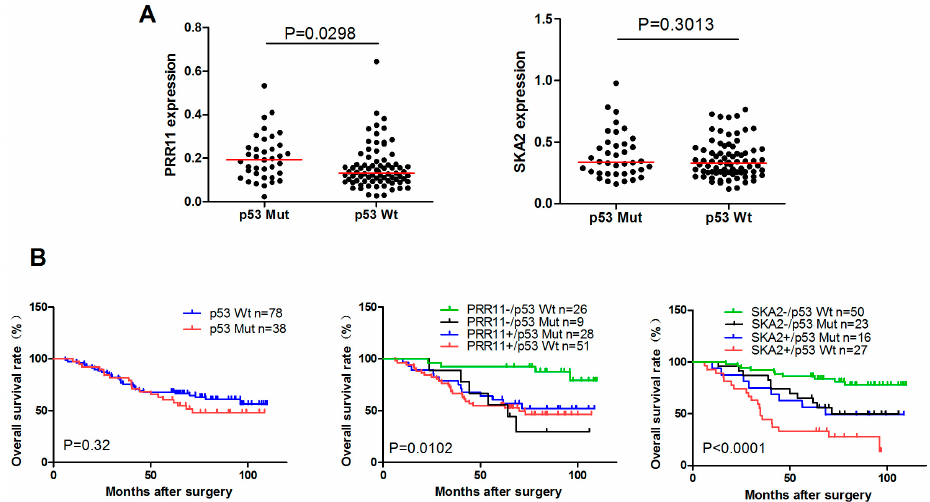
Figure 5. Clinical significance of p53-mediated PRR11-SKA2 repression in lung cancer. ( A ) Expression levels of PRR11 and SKA2 with different p53 status in lung cancer. The expression levels of PRR11 and SKA2 were analyzed in patients with wild type p53 or mutant p53 in the Nagoya lung cancer cohort; ( B ) Survival analysis of PRR11 and SKA2 expression with different p53 status in lung cancer. Kaplan–Meier plot of overall survival of lung cancer patients in the Nagoya University cohorts.